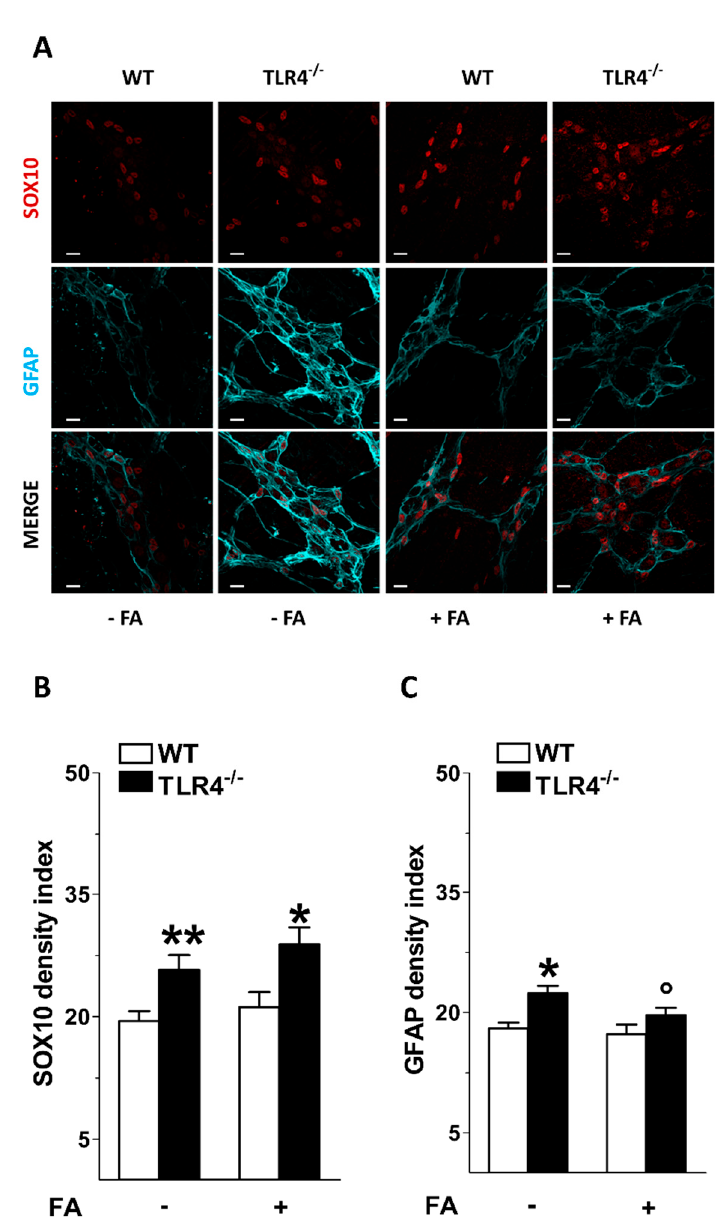
Figure 2. E ff ect of fluoroacetate (FA) treatment on enteric glial phenotype. ( A ) Representative confocal microphotographs showing the distribution of SOX10 (red) and GFAP (cyan) in ileal LMMPs of WT and TLR4 − / − mice in the presence or absence of 10 µ M FA (bars = 22 µ m). ( B , C ) Analysis of SOX10 and GFAP density index in ileal LMMPs of WT and TLR4 − / − mice in the presence or absence of 10 µ M FA. Data are reported as mean ± SEM for all panels. * P < 0.05, ** P < 0.01 vs. WT; ◦ P < 0.05 vs. respective control without FA; N = 6 mice/group.